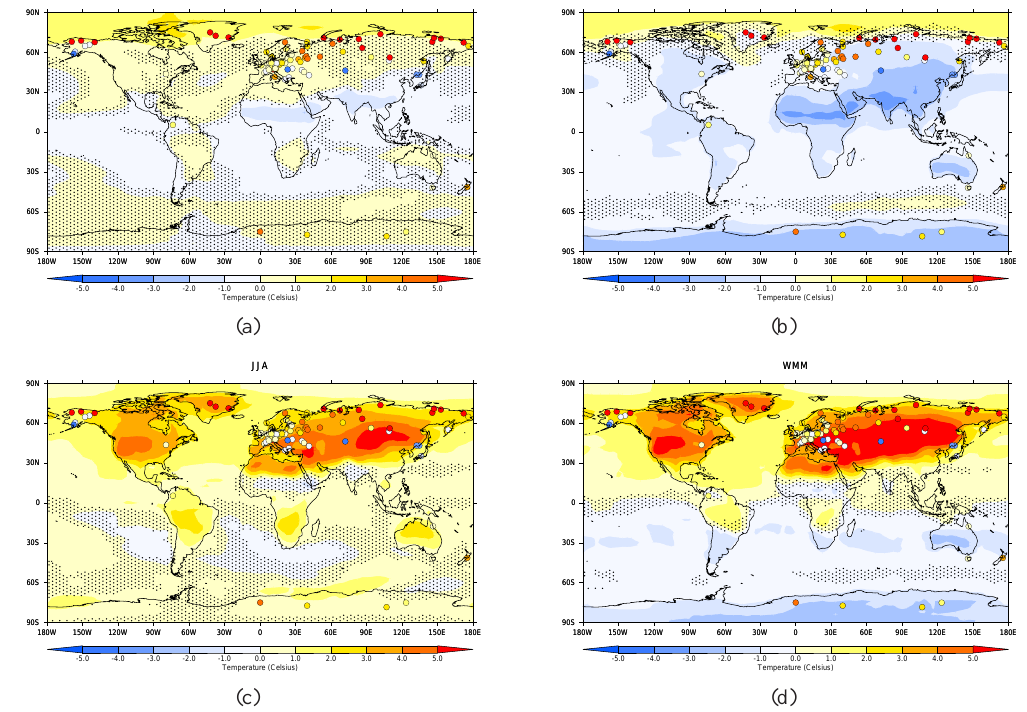
Fig. 6. Simulated surface air temperature change, LIG minus pre-industrial, for the model ensemble. (a) Annual mean, (b) DJF, (c) JJA, and (d) warm-month mean (WMM). Stippled regions show regions where less than 70% of the model simulations agree on the sign of the temperature change. Also shown are the terrestrial data points of Turney and Jones